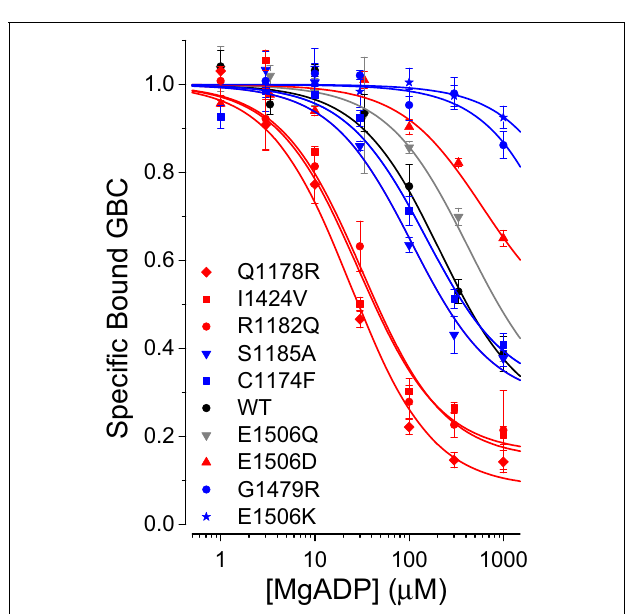
FIGURE 4 | MgADP-induced conformational switching inWT and SUR1 mutants .